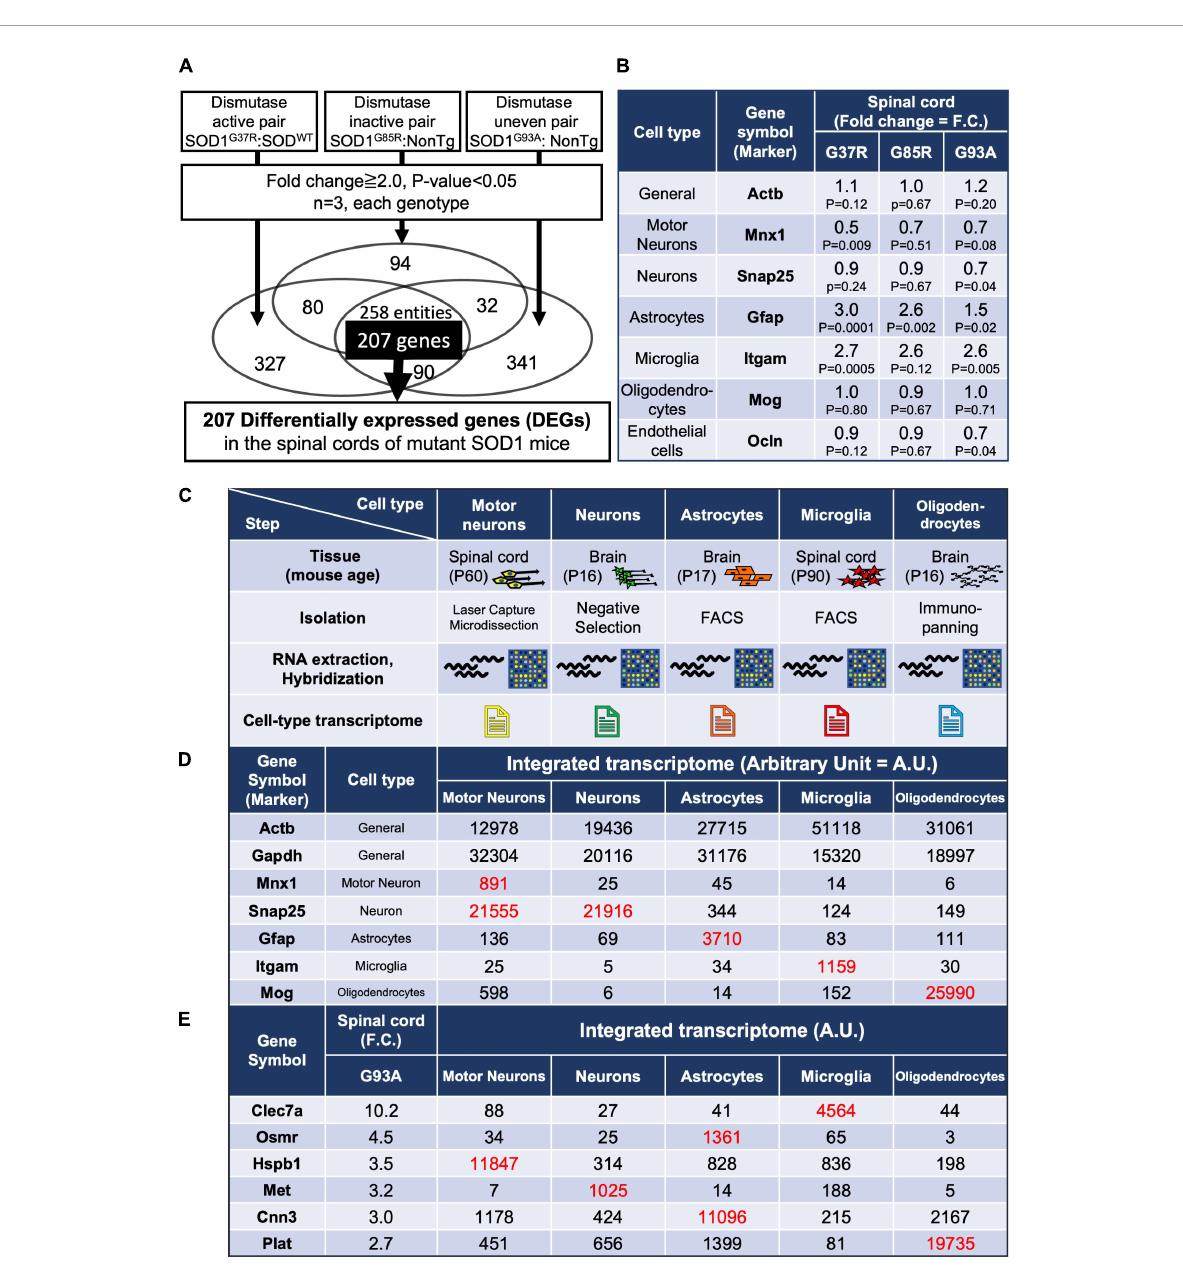
FIGURE1 Gene expression analysis of whole spinal cords in mutant SOD1 mice, and establishment of an integrated transcriptome. (A) Experimental design to identify genes in the lumbar spinal cords of mutant SOD1 mice that are reliably changed by mutant SOD1 toxicity, independent of SOD1 activity. A total of 207 overlapping, differentially expressed genes (DEGs) were extracted that were commonly changed by comparison in three pairs. (B) Gene expression changes in general or in cell-type marker genes. (C) Characteristics of each cell type sample used to create the integrated transcriptome. Motor neurons were obtained by Laser Capture Microdissection from spinal cord. Neurons were obtained by negative selection using residual samples after removal of oligodendrocyte lineage cells and microglia by immunopanning, astrocytes by FACS, and endothelial cells and pericytes by immunopanning, from brain cell suspensions. Reported cell purity, negative for an astrocyte marker (S100 β ), oligodendrocyte markers (GalC, MOG, and O1), and a microglial and pericytic marker (BSL1 lectin), was > 99.9%. Astrocytes were obtained from S100 β -EGFP positive cells purified by FACS after the removal of oligodendrocytes by immunopanning from brain cell suspensions. Reported cell purity was > 99.5% by S100 β -EGFP positivity. Microglia were obtained from CD11b-positive cells purified by FACS from dissociated cells from lumber spinal cords. Oligodendrocytes were obtained by anti-MOG immunopanning from brain cell suspensions, which yielded 100% MOG-positive, > 95% MBP-positive, and 0% NG2-positive cells. (D) The data from the CEL file of each cell type were normalized to show the relative expressions of each gene in each cell type (integrated transcriptome). As shown in red (hereafter, red font shows values to be focused on along with our explanation), the marker genes of each cell type itself were highly enriched. (E) The integrated transcriptome of representative genes in 207 DEGs shows that Clec7a, Osmr and Cnn3, Hspb1, Met, and Plat are expressed at relatively high levels in microglia, astrocytes, motor neurons, neurons, and oligodendrocytes, respectively. FACS, fluorescence-activated cell